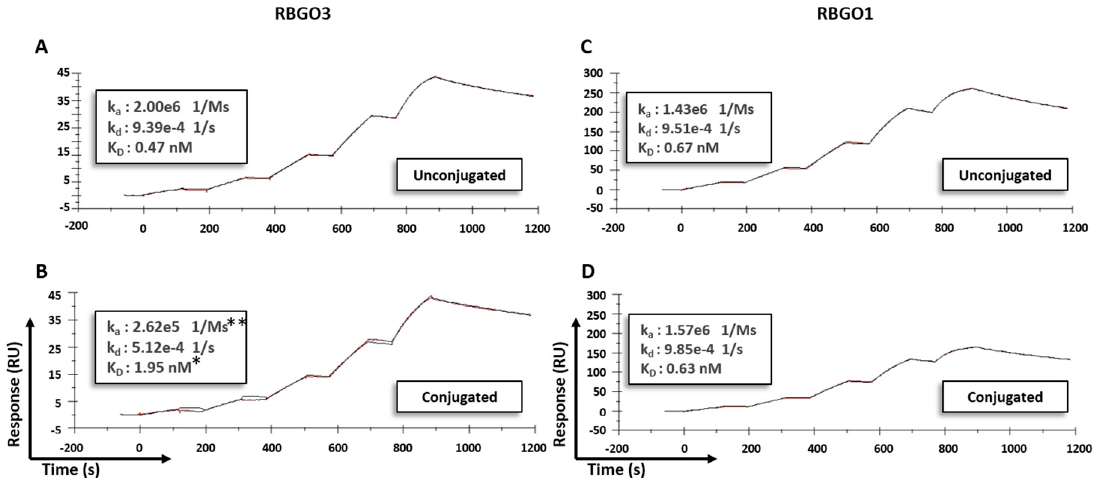
Figure 5. The effect of conjugation on antibody-antigen binding kinetics is antibody-dependent. Antibodies were captured onto a Sensor Chip CM5 via an amine coupled anti-mouse antibody. Single-cycle kinetics experiments were performed. RBGO3 antibody ( A ) and RBGO3-ADC ( B ) were exposed to the aa198–217 peptide (2.5 to 200 nM), and the RBGO1 antibody ( C ) and RBGO1-ADC ( D ) were exposed to rRAGE (2.5 to 200 nM). Kinetics were determined using a one-to-one binding model. Curves displayed are exemplar curves from three independent experiments and data are the mean. * p < 0.05, ** p < 0.01 compared to the unconjugated antibody.